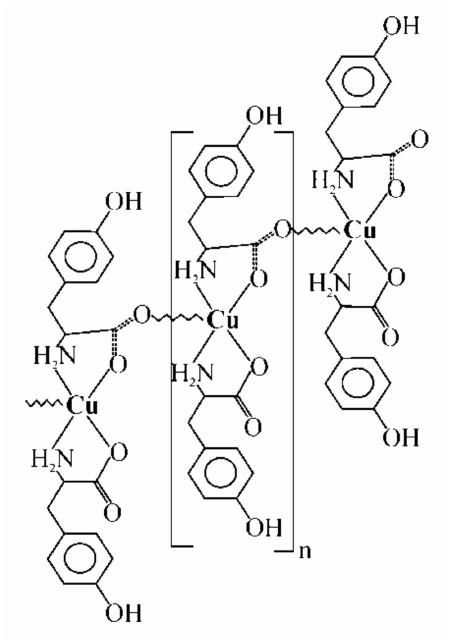
Figure 1. The schemes of [Cu(L-tyr) 2 ] n .